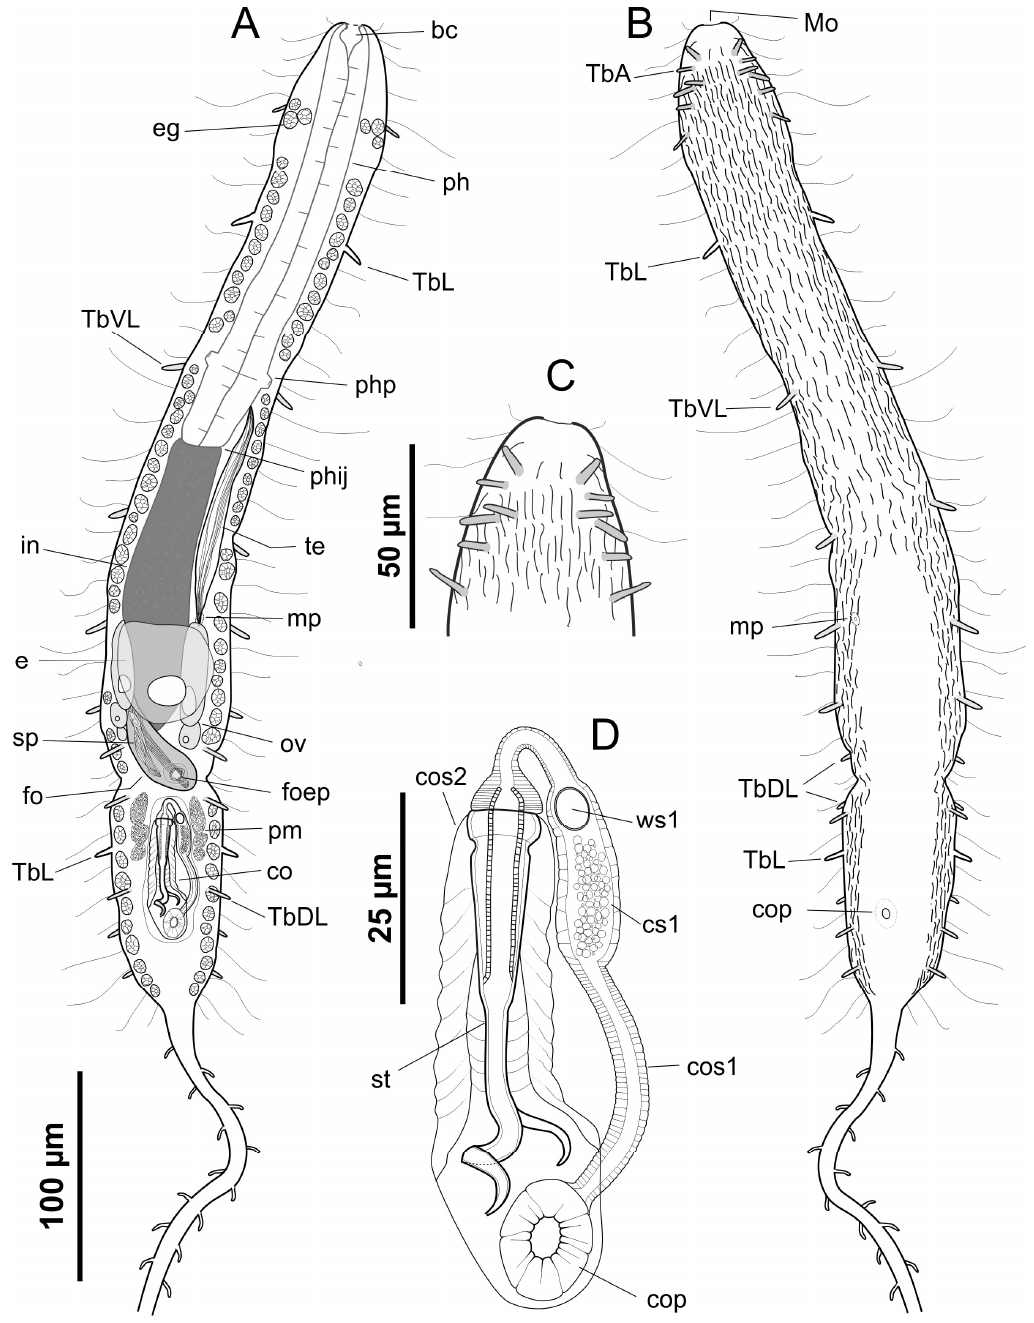
Figure 1. Line art illustration of Urodasys bi fi dostylis sp. nov. ( A ) Habitus , showing the internal anat- omy seen from a dorsal view; ( B ) habitus , ventral view; ( C ) detail of the anterior end, ventral view, showing the anterior adhesive tubes; ( D ) detail of the caudal organs, ventral view, showing